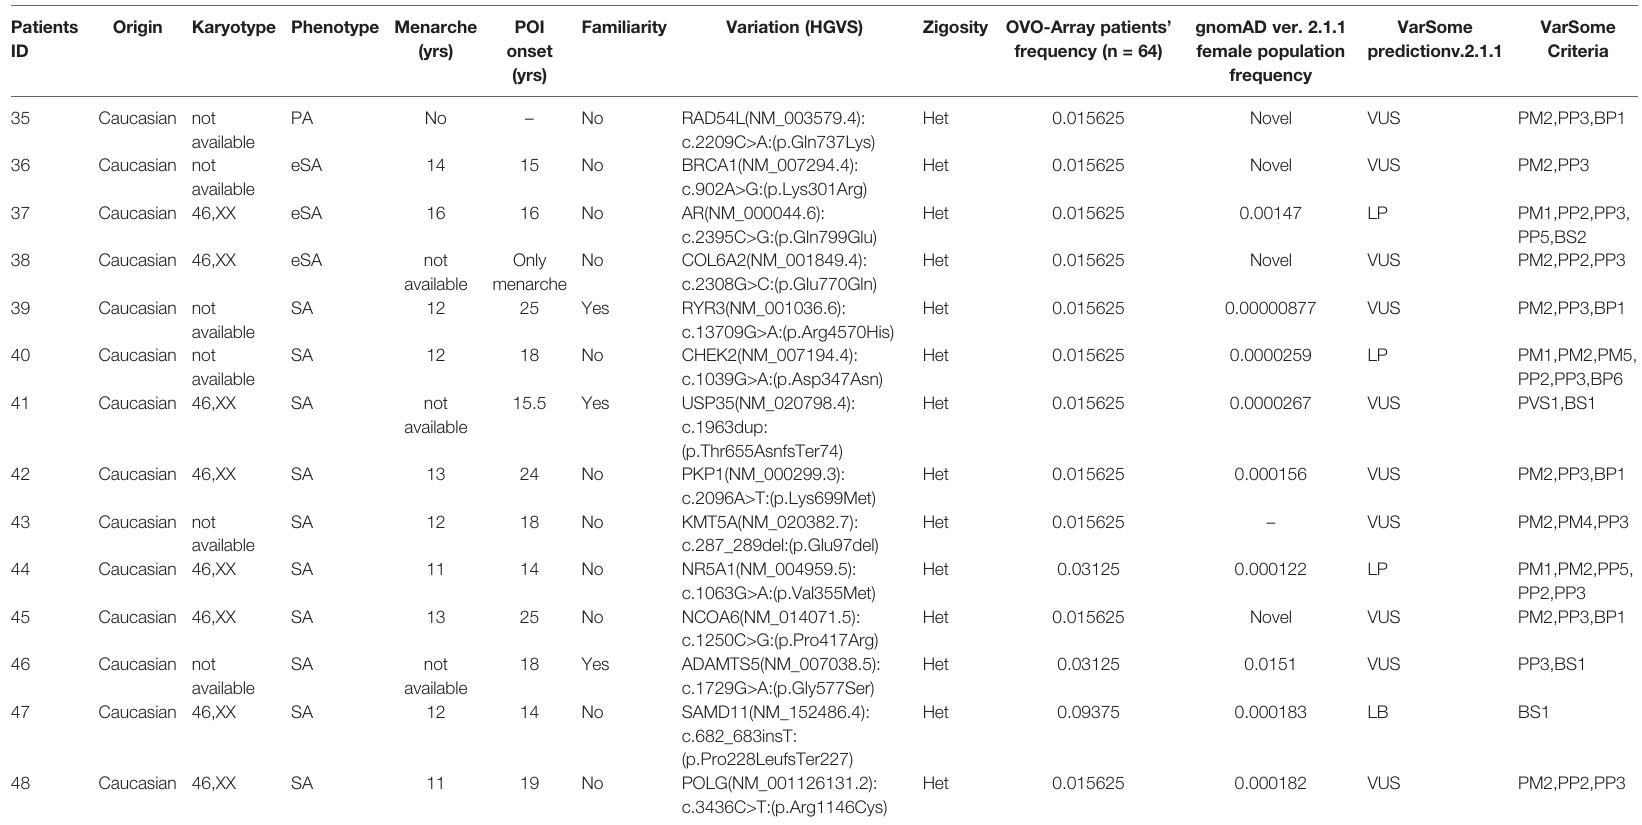
TABLE 6 | Correlation among severity, phenotype, and pathogenicity predictions in patients with only 1 variant in potentially POI